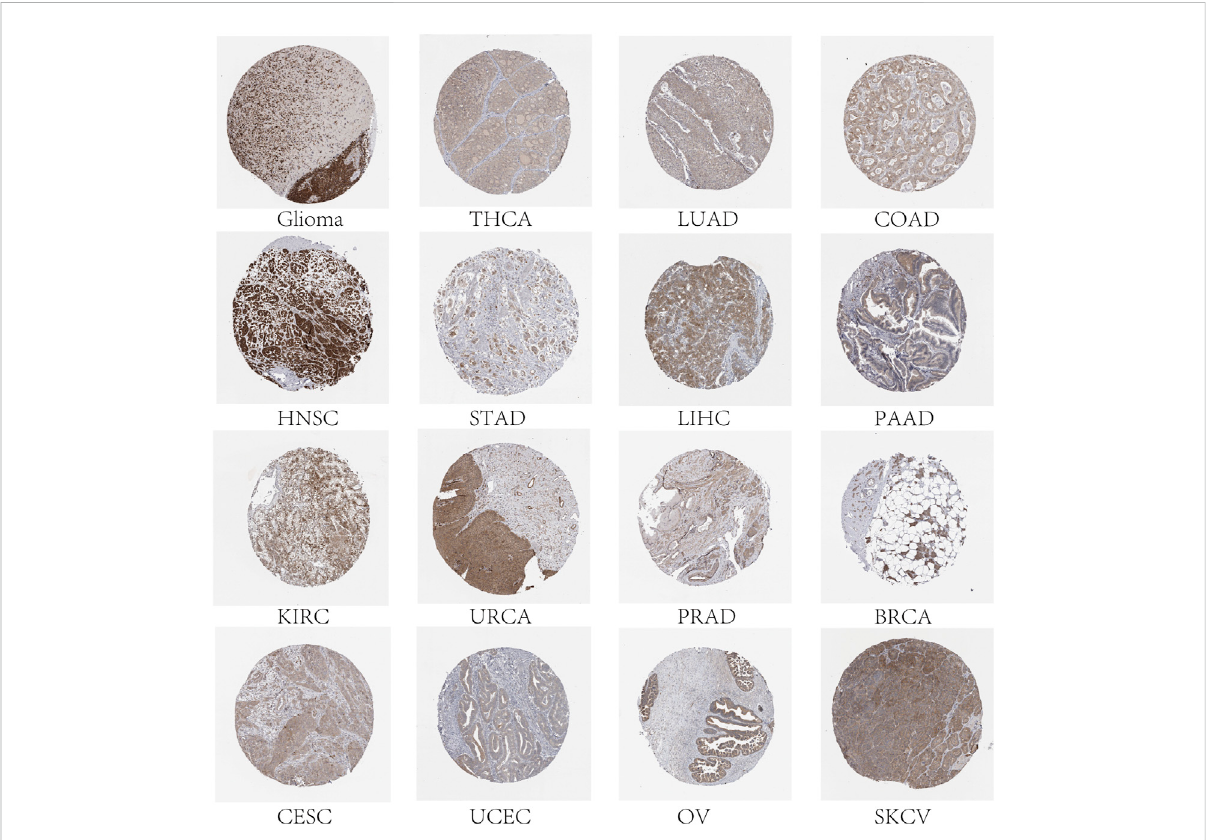
FIGURE 2 Expression level of the FAM83H protein. Immunohistochemical staining results showed expression of the FAM83H protein in 16 cancer